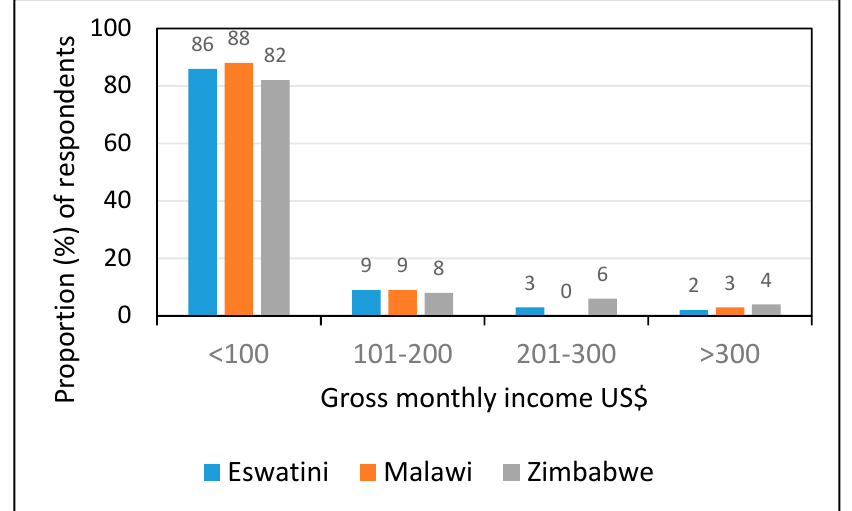
Figure 3. Monthly gross income from fibre craft trade in Eswatini, Malawi and Zimbabwe.